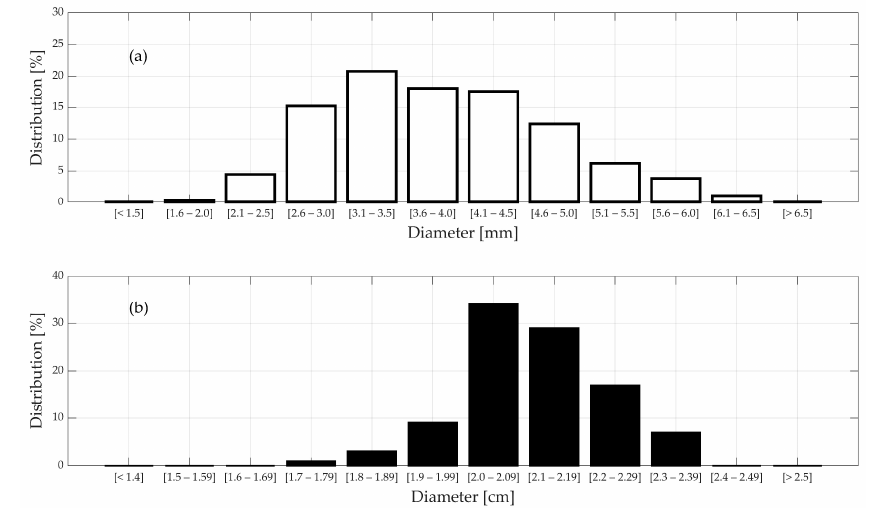
Figure 4. Bamboo diameter distribution for ( a ) model scale and ( b ) prototype.